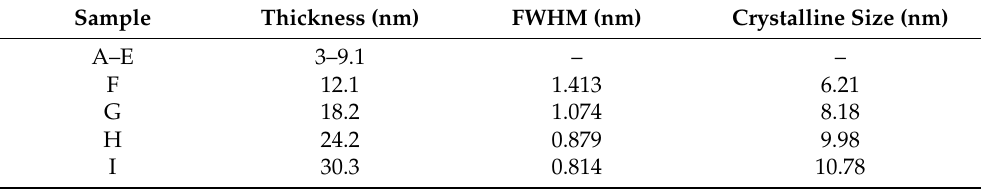
Table 3. The crystalline scales of the as-deposited various AgNP layers.